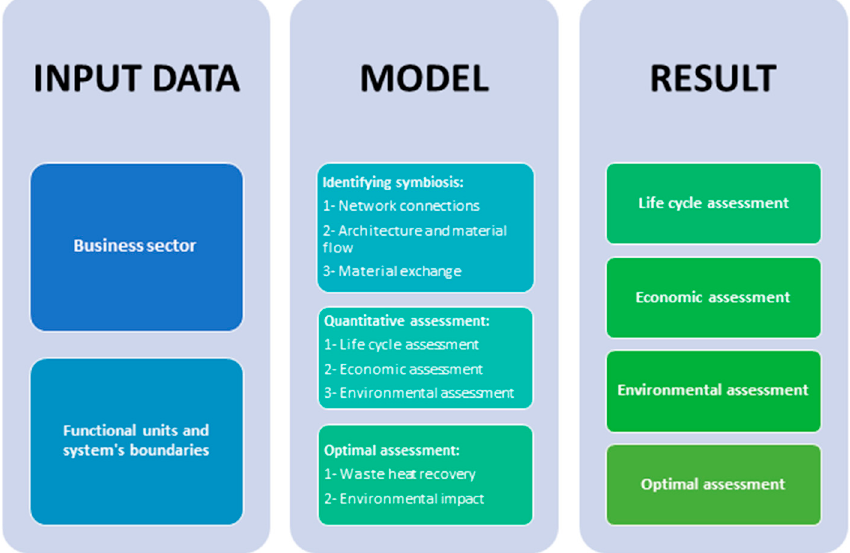
Figure 1. Sustainability model of industrial symbiosis.